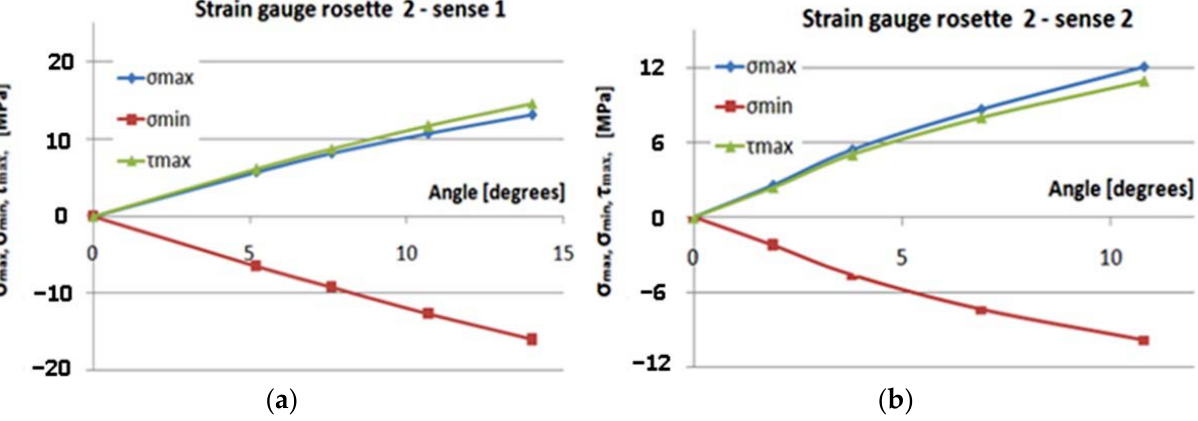
Figure 18. Gauge2–sense 1,2: the variation of the maximum normal main stress σ max , σ min , and τ max , in relation to the angle of rotation. ( a ) Sense 1; ( b ) sense 2.